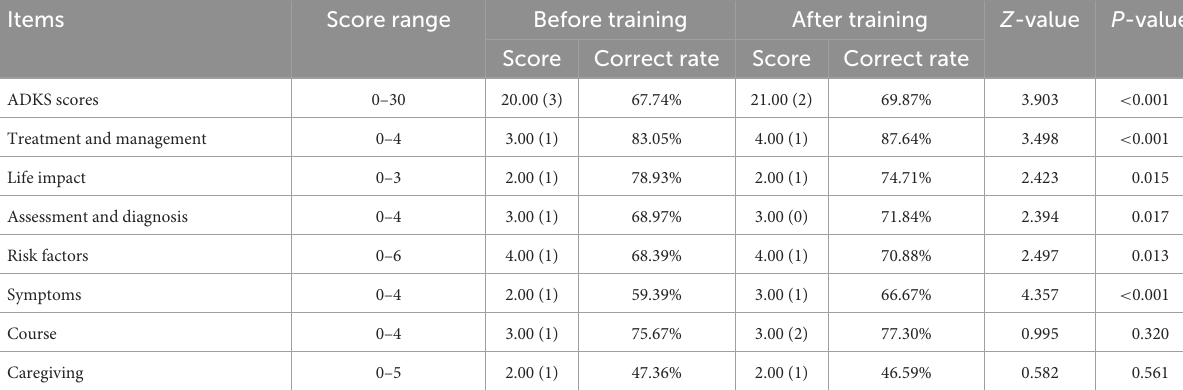
TABLE 4 ADKS content domains and scores of 261 people. Items